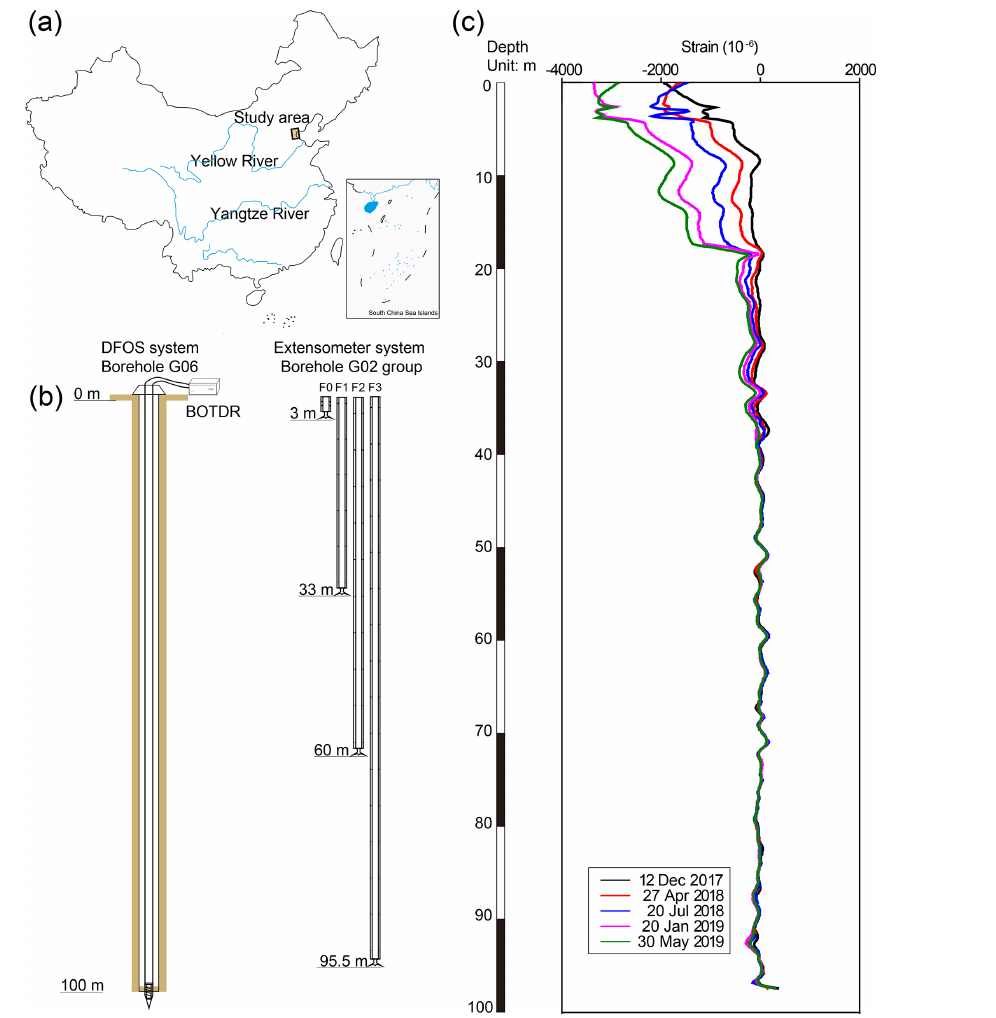
Figure 1. Location of G06 borehole and the DFOS system of land subsidence. (a) Location of study area, China. (b) DFOS system and extensometers system. (c) Strain measured along 5-FPC.